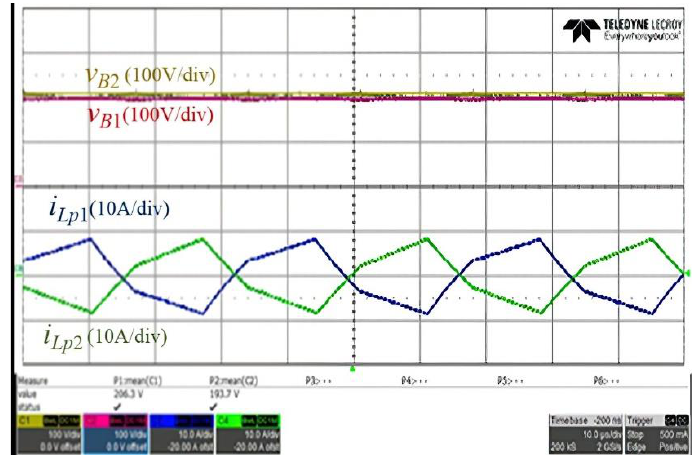
Figure 18. Experimental waveforms of the battery module voltage and current of the transformers